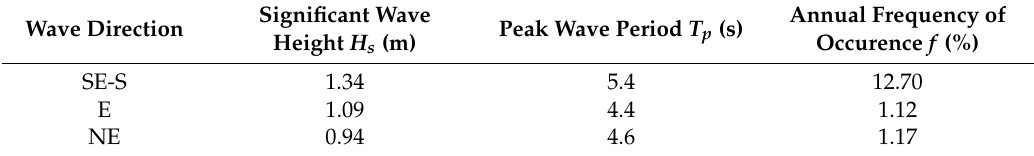
Table 2. Characteristics of the three representative waves used for the Paralia Katerinis beach runs. Wave